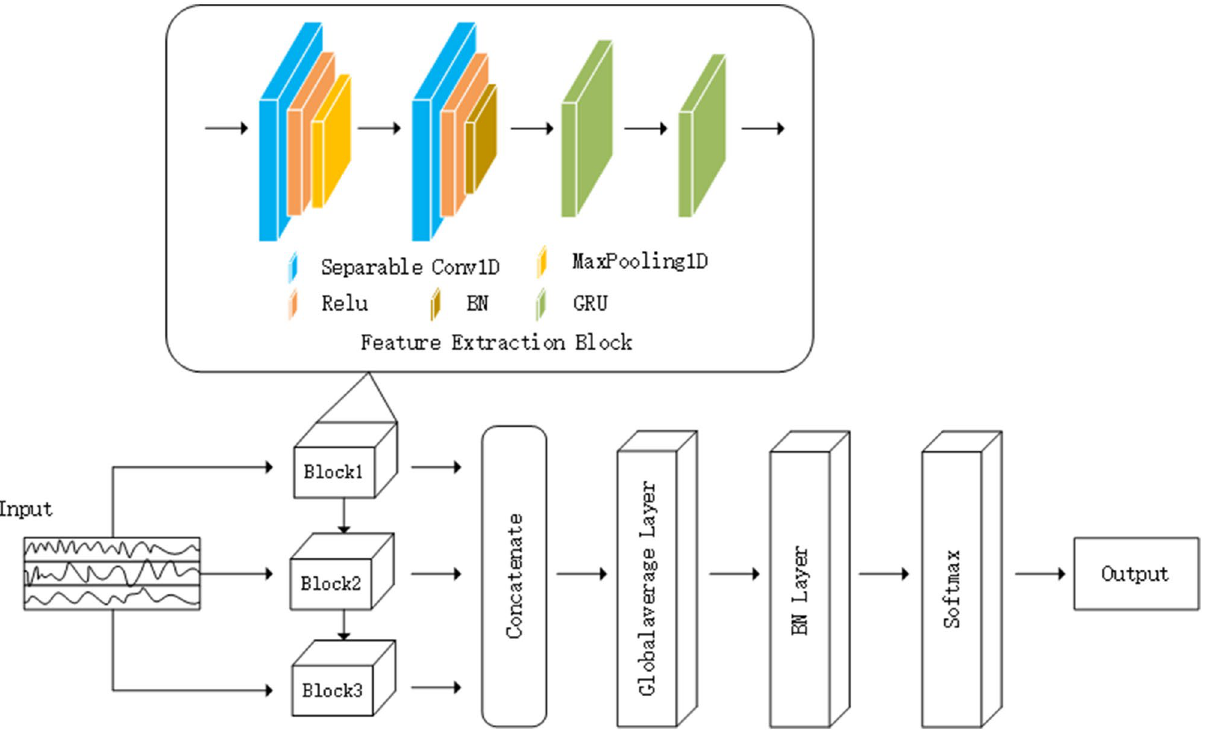
Figure 2. The network architecture of the proposed